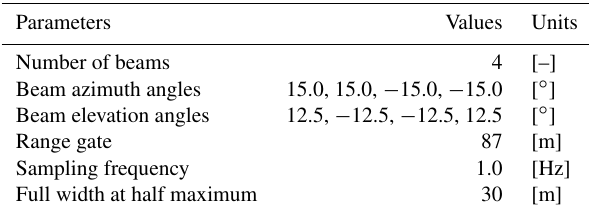
Table 2. Parameters of the simulated pulsed lidar system.